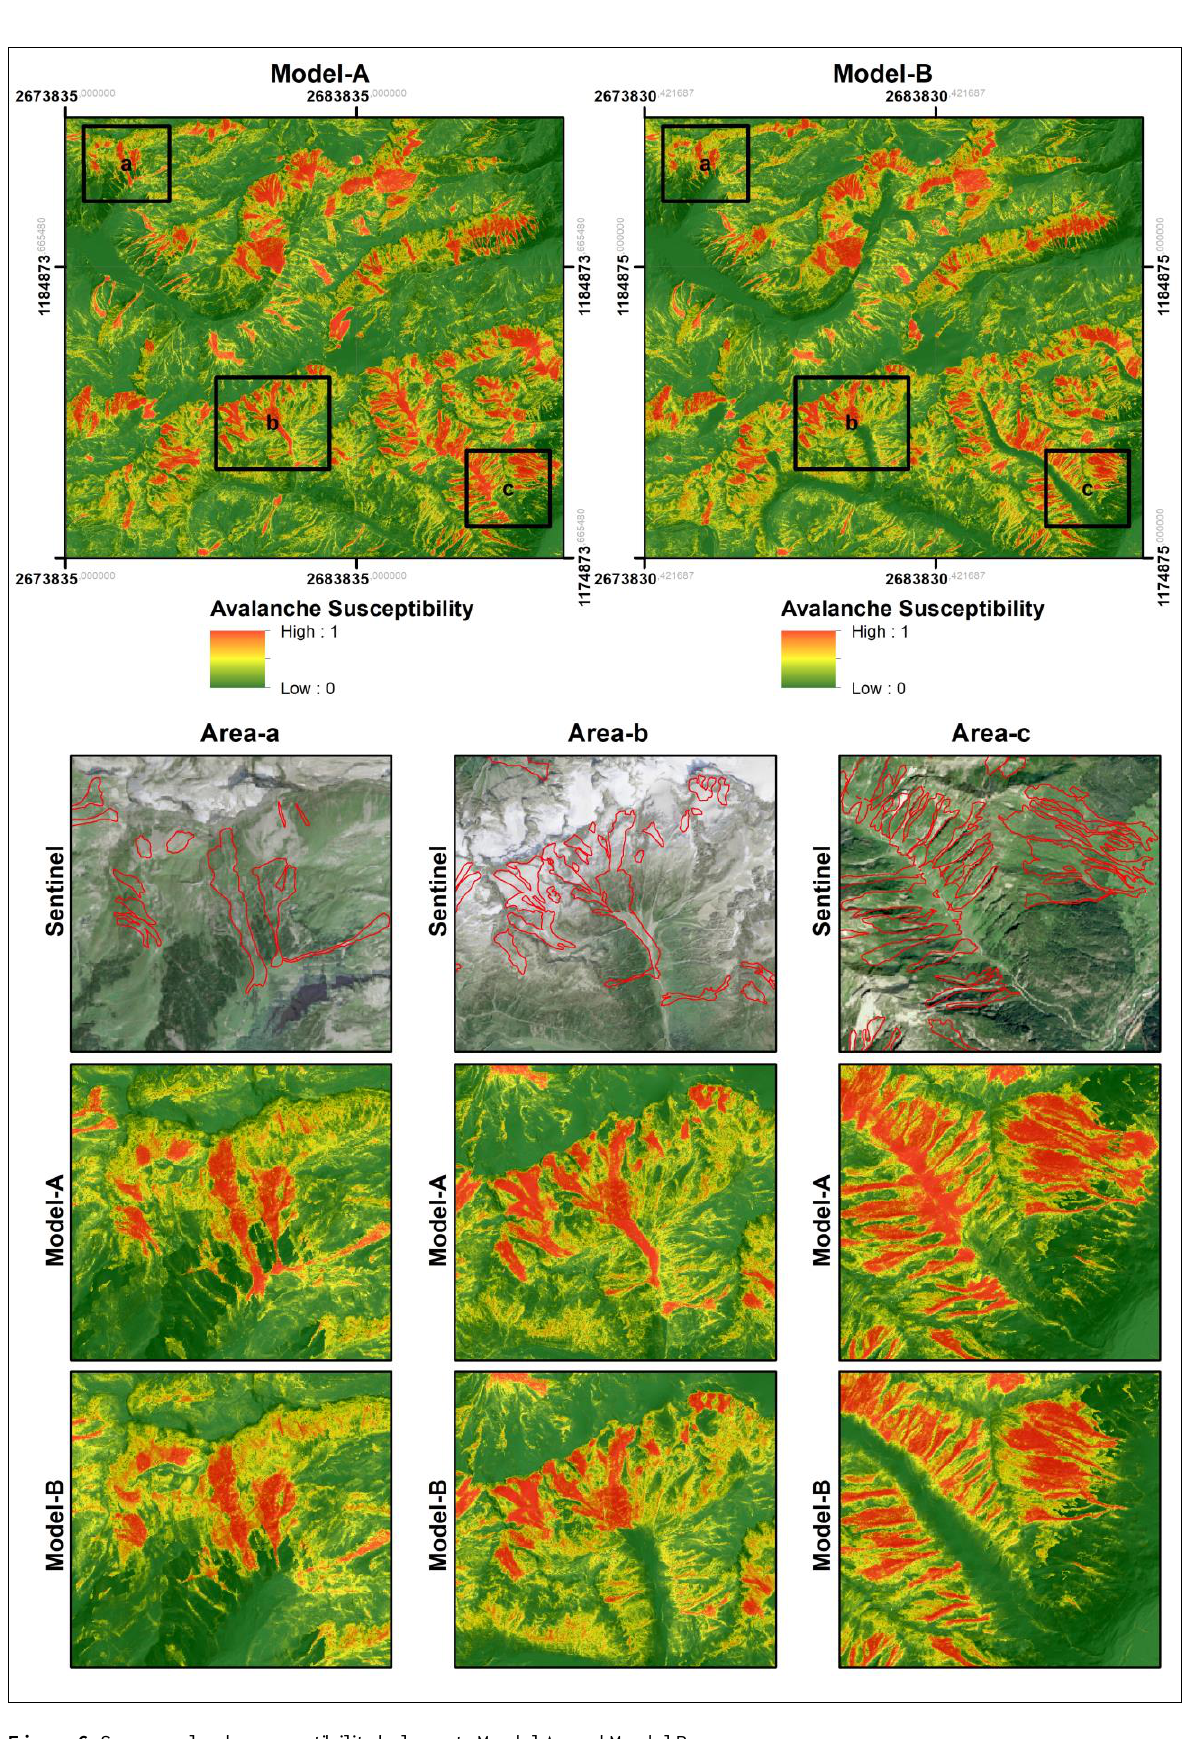
Figure 6. Snow avalanche susceptibility belongs to Model-A, and